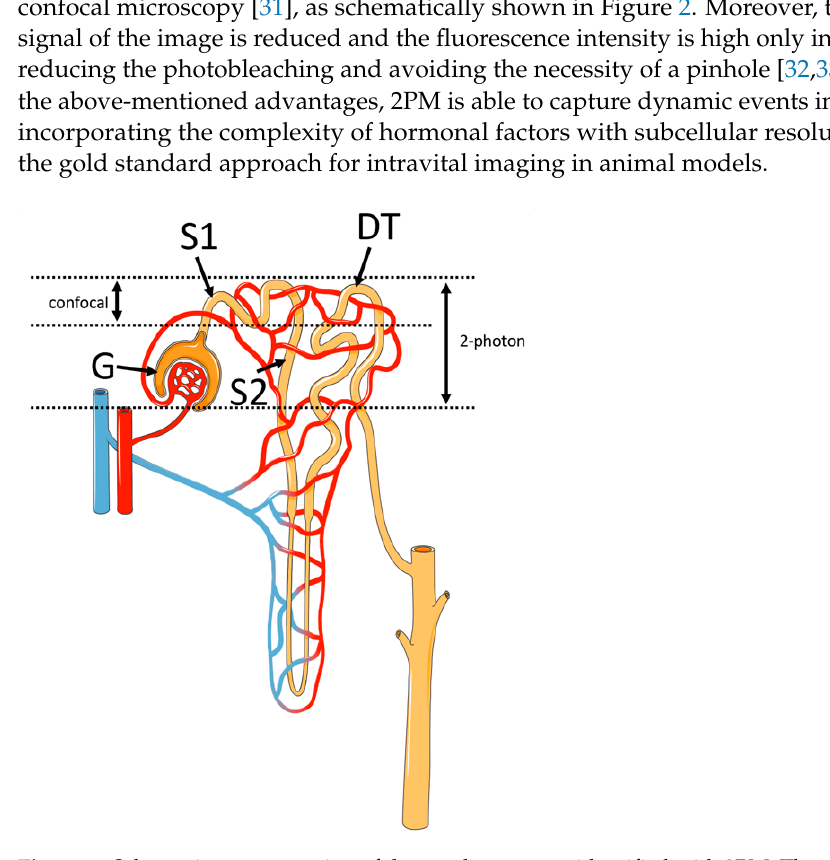
Formatted: Highlight